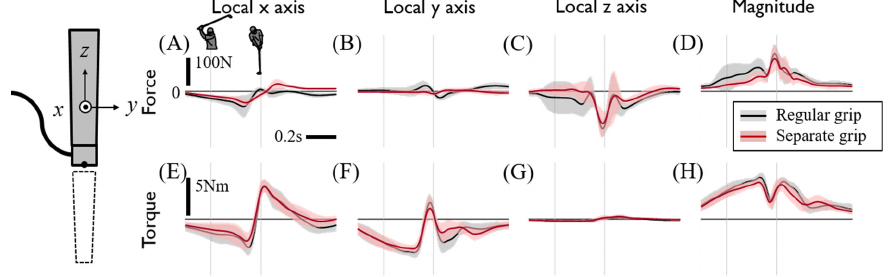
Figure 10. Internal grip force and torque under regular and separate grip posture conditions. Each row shows the force ( A – D ) and torque ( E – H ). Each column shows x, y, and z values and the magnitude of force and torque at the club’s local coordinates. The black line shows the internal grip force under regular grip posture conditions, and the red line shows the internal grip force under separate grip posture conditions. The forces and torques act on the left-hand grip at the sensing reference origin of the sensor and are the averages of driver swing data on all subjects. The two thin gray vertical lines indicate the backswing top and